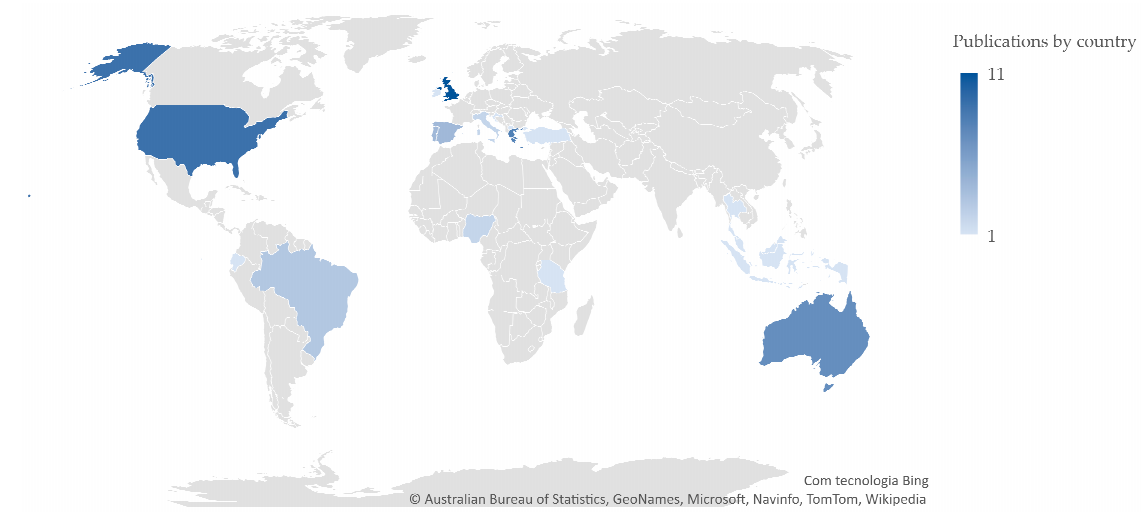
Figure 6. Geographical distribution.